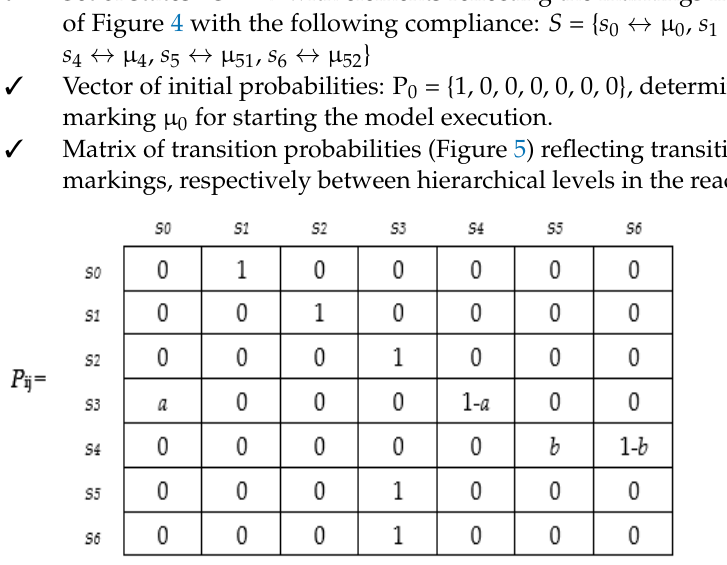
Figure 5. Matrix of transition probabilities